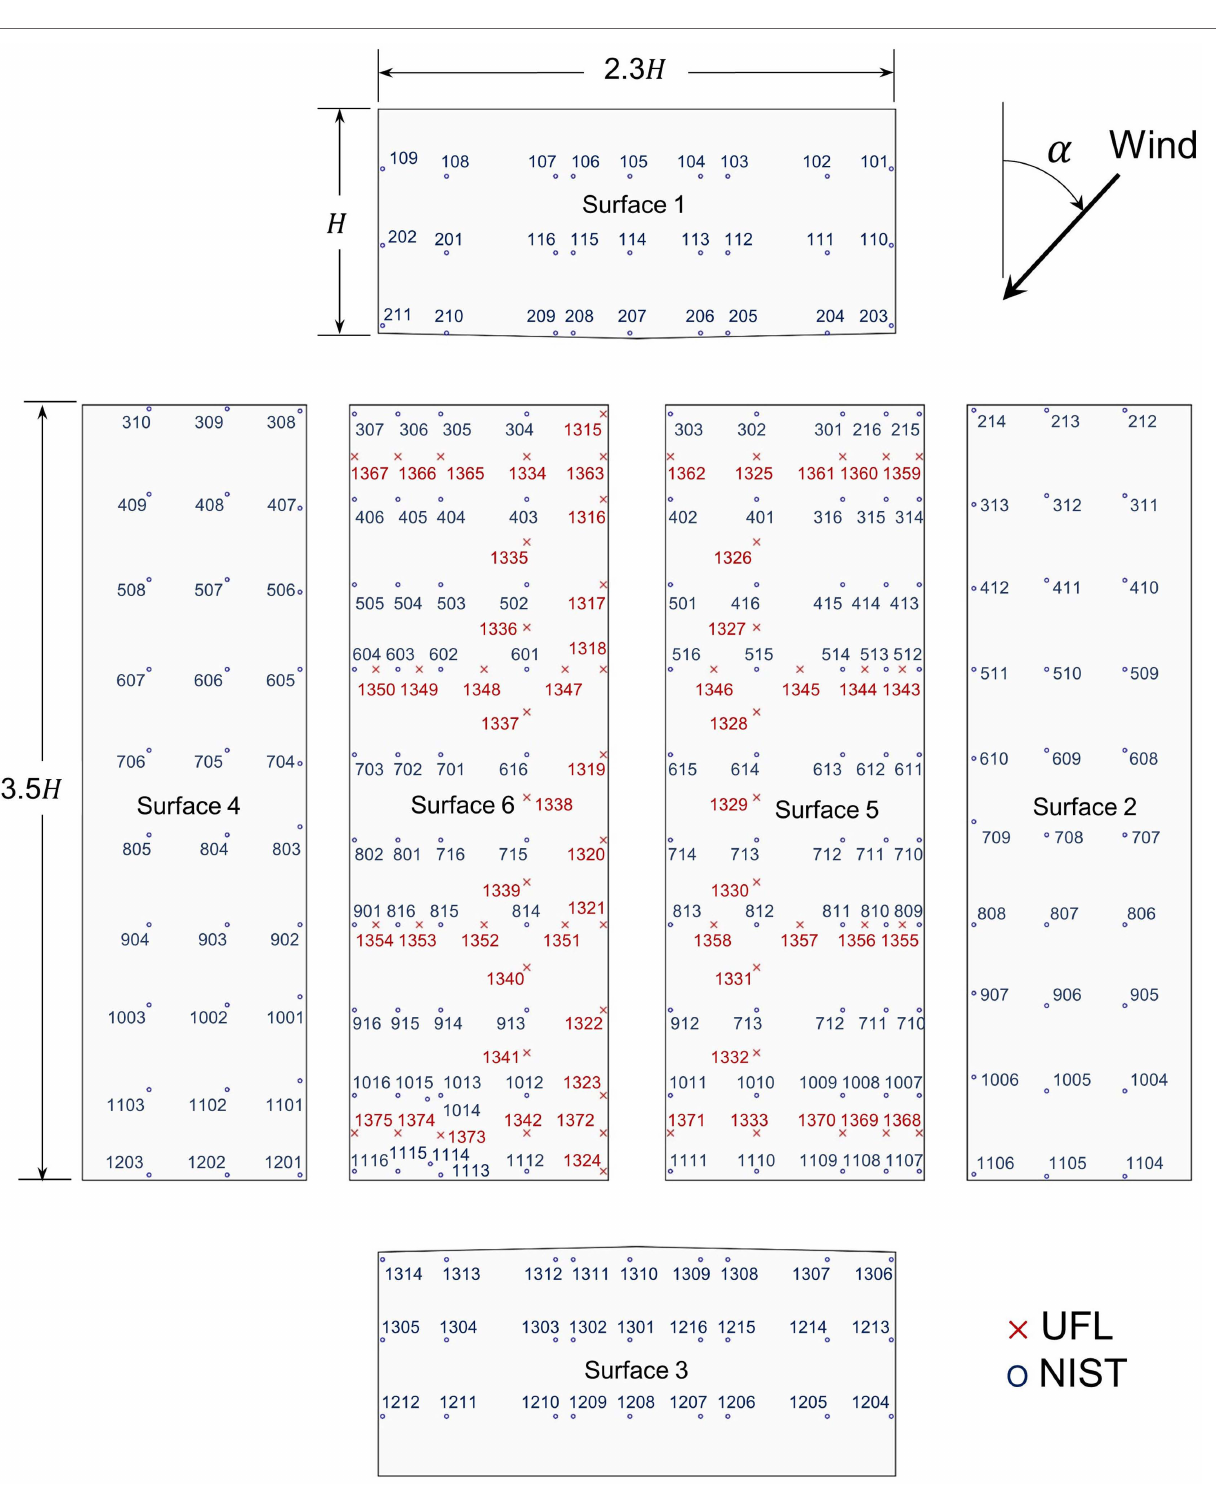
Frontiers in Built Environment |